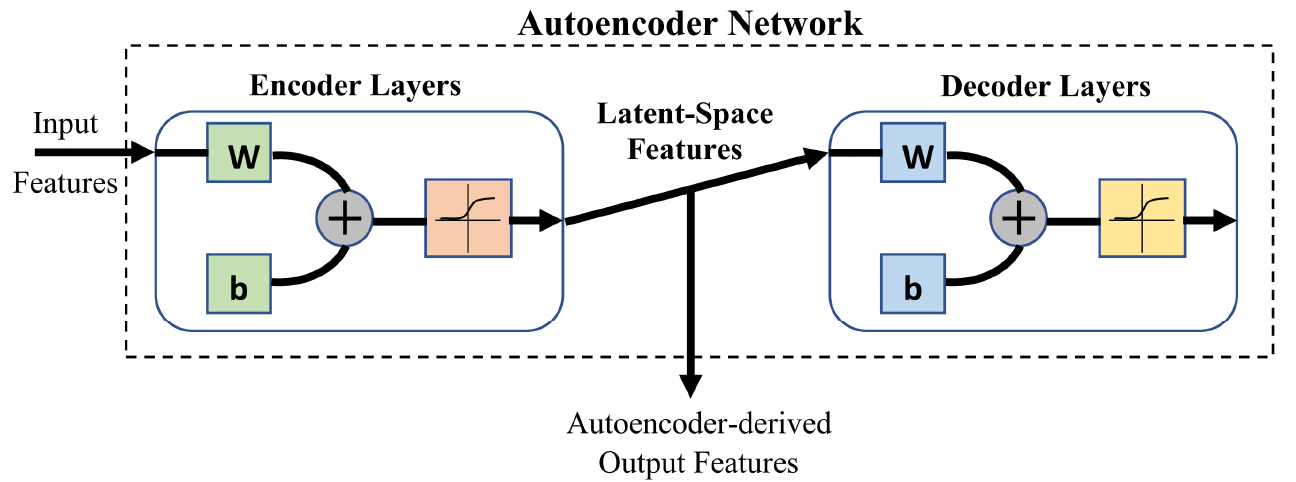
Figure 4. Structure of the autoencoder deep learning neural network; ‘W’ and ‘b’ are the weight and bias of the network neurons.